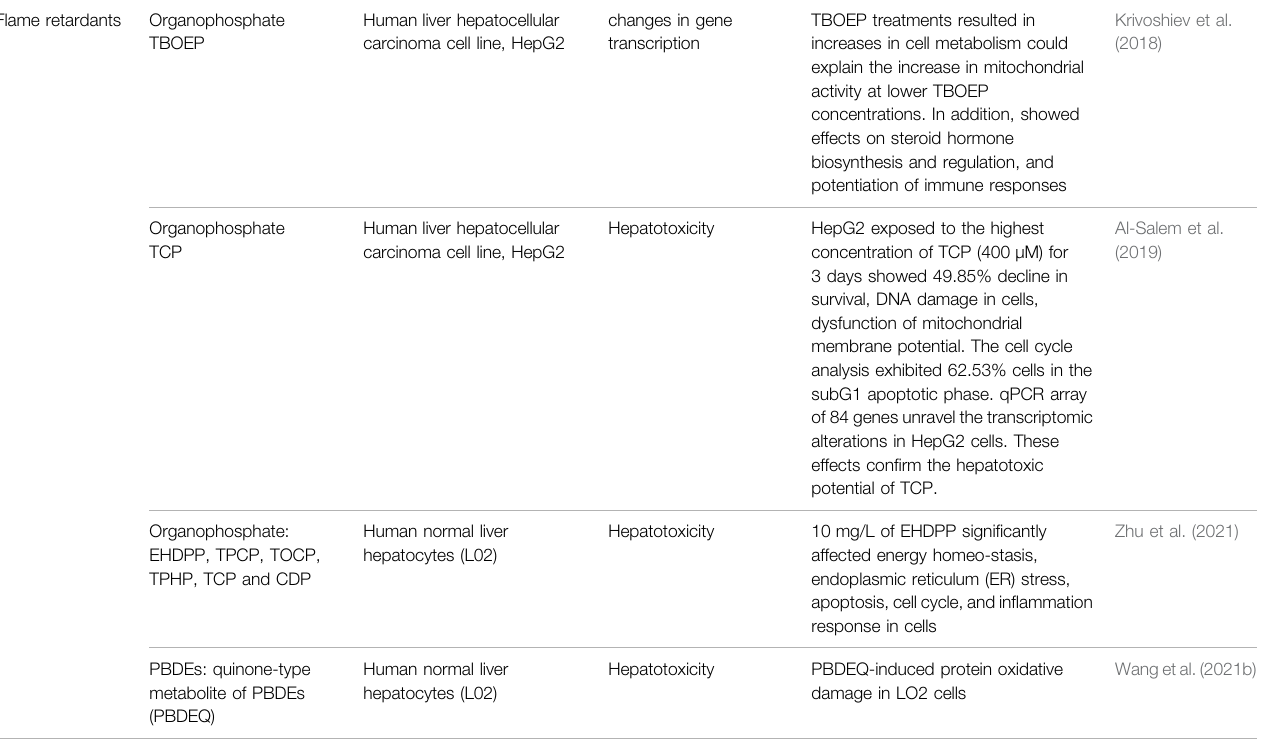
TABLE 4 | ( Continued ) Examples toxicological assays of plastic additives using human